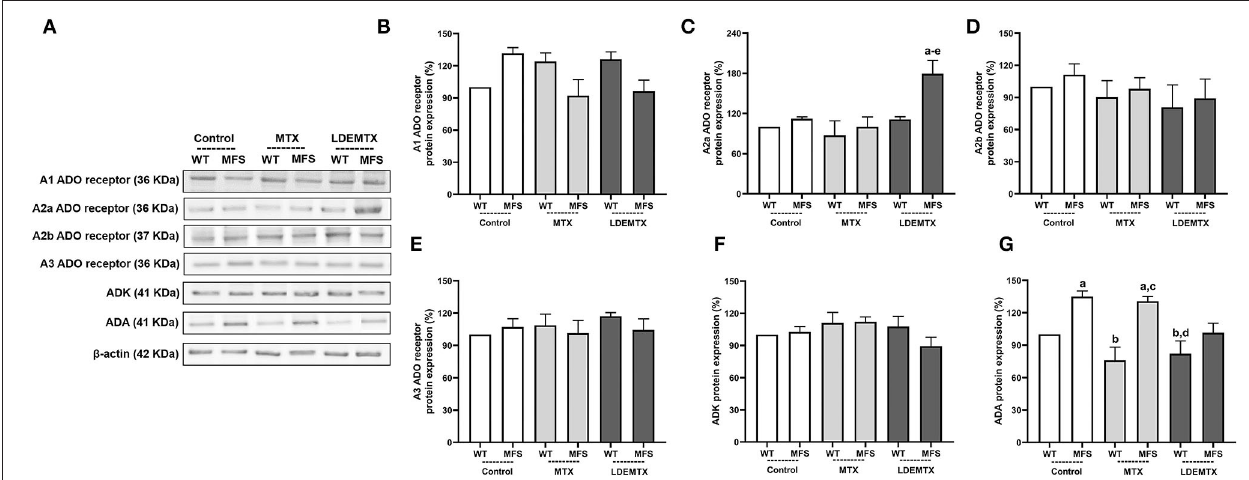
FIGURE 6 | Representative bands (A) and graphs showing western blot analysis of anti-adenosine A1 receptor (A1) (B) , anti-adenosine A2a receptor (A2a) (C) , anti-adenosine A2b receptor (A2b) (D) , and anti-adenosine A3 receptor (A3) (E) , adenosine receptors and by anti-adenosine kinase (ADK) (F) , and anti-adenosine deaminase (ADA) (G) protein expression in WT and MFS mice at 6 months of age, treated with MTX and LDEMTX. Values were normalized for the expression of β -actin, and results were expressed as a percentage of WT WT-control group means. Data are means ± SEM of a pool of aorta segments, comprising ascending aorta, aortic arch, and descending aorta ( n = 5, per group). (a) p < 0.05 vs. WT-control; (b) p < 0.05 vs. MFS-control; (c) p < 0.05 vs. WT-MTX; (d) p < 0.05 vs. MFS-MTX; and (e) p < 0.05 vs. WT-LDEMTX.